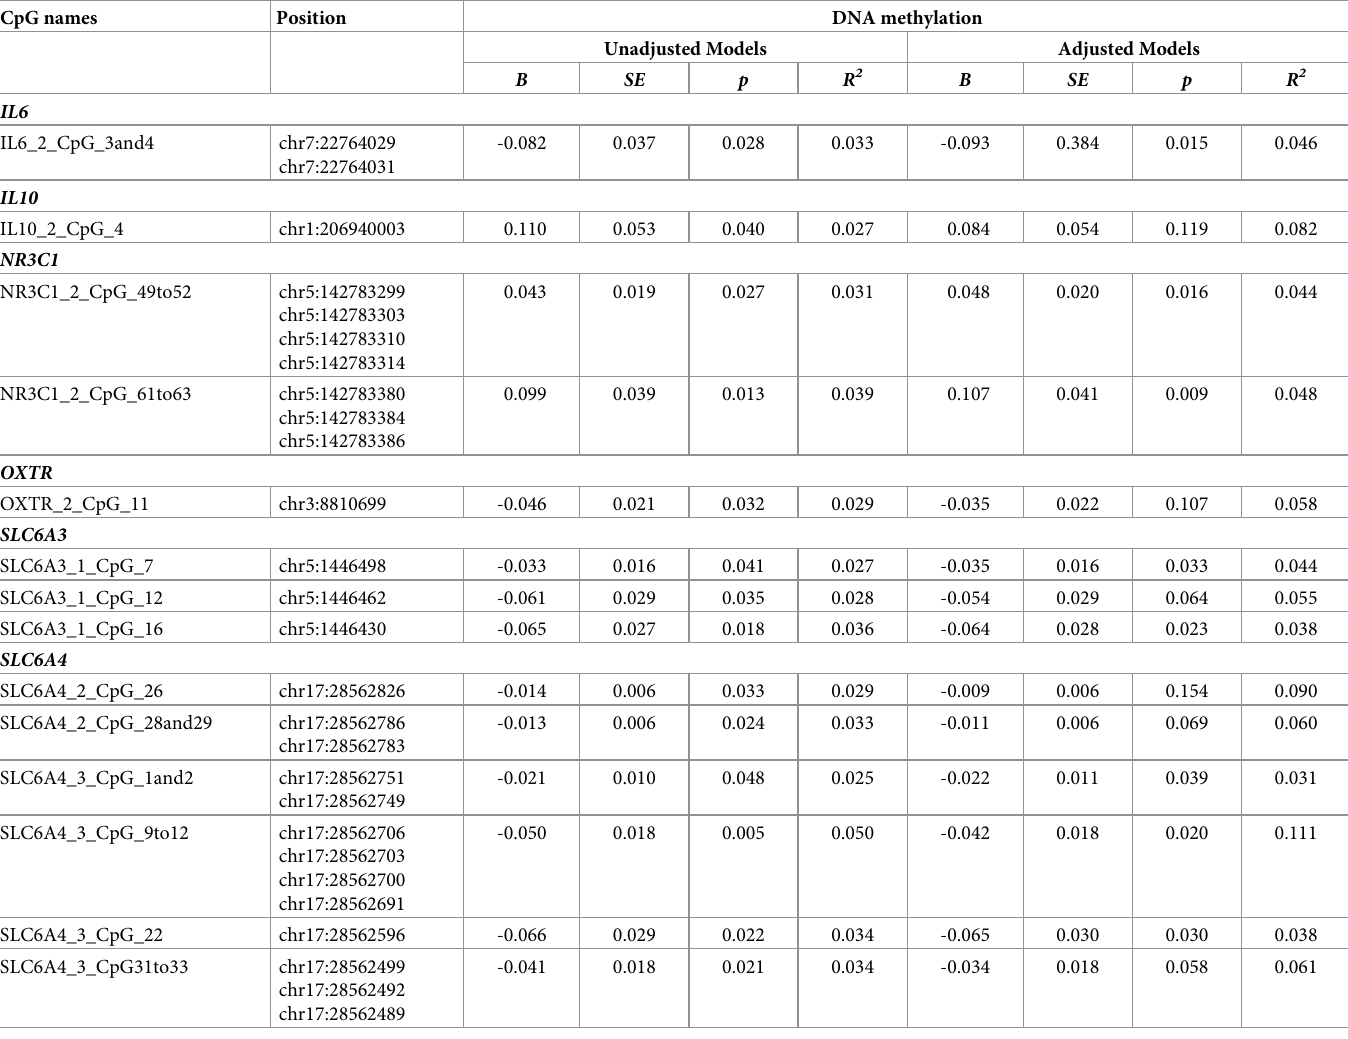
Table 2. Significant associations between depressive symptoms and DNA